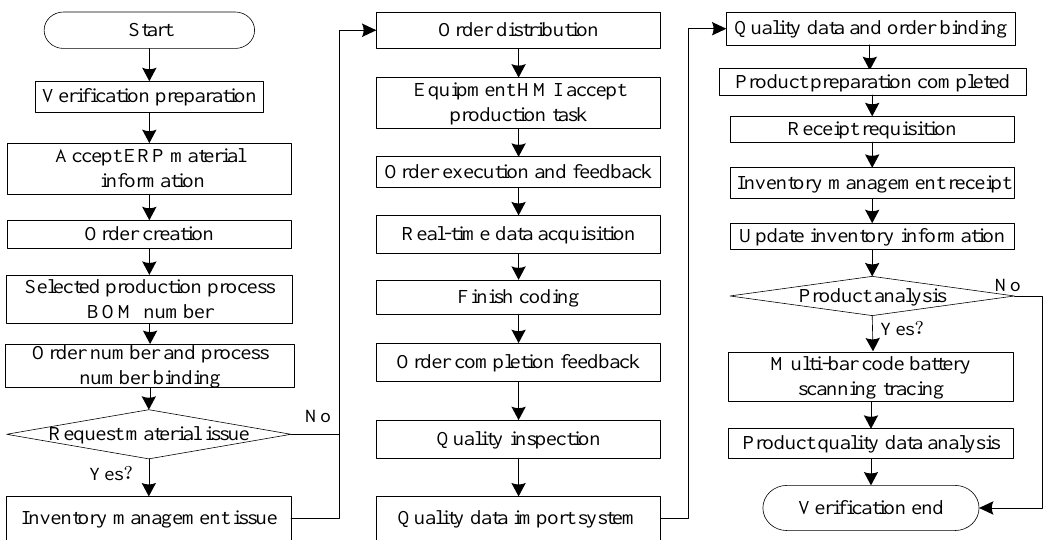
Figure 14. Field application test flow chart.